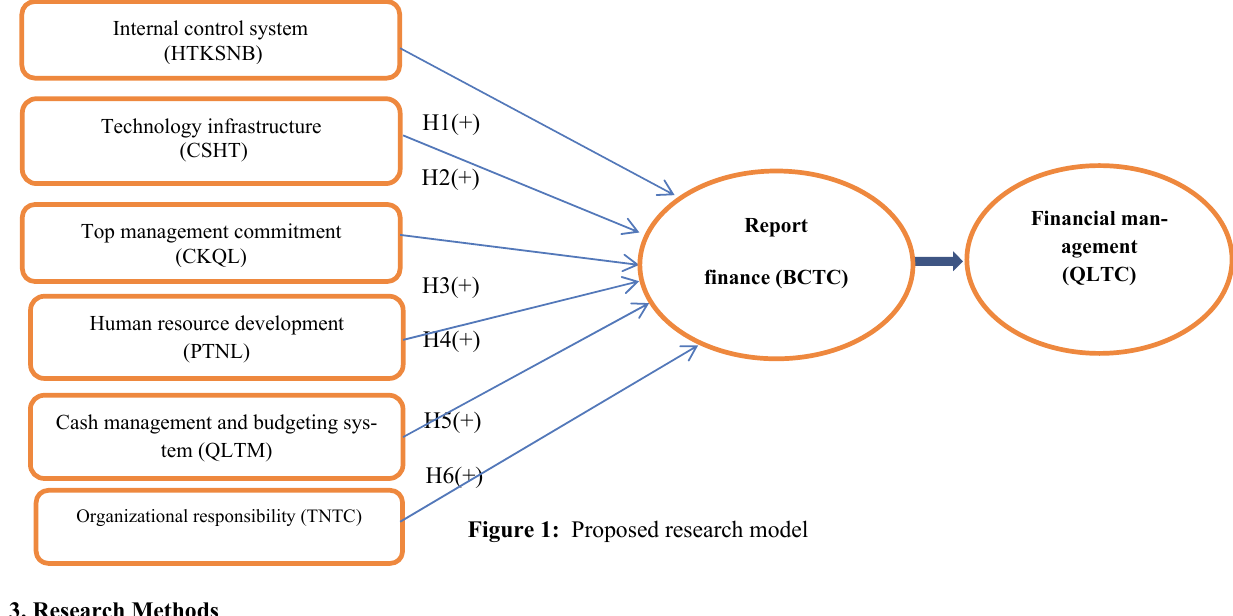
Figure 1: Proposed research